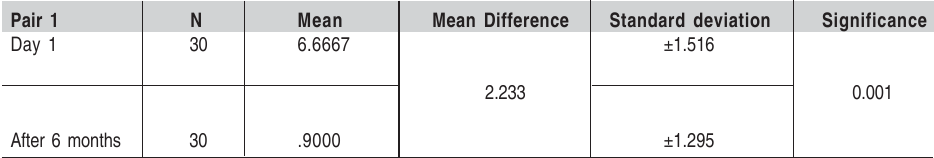
Table 2. A comparative analysis of oral stereognostic ability test on the day of denture fit and insertion and after 6 months of denture usage by using paired sample t-test